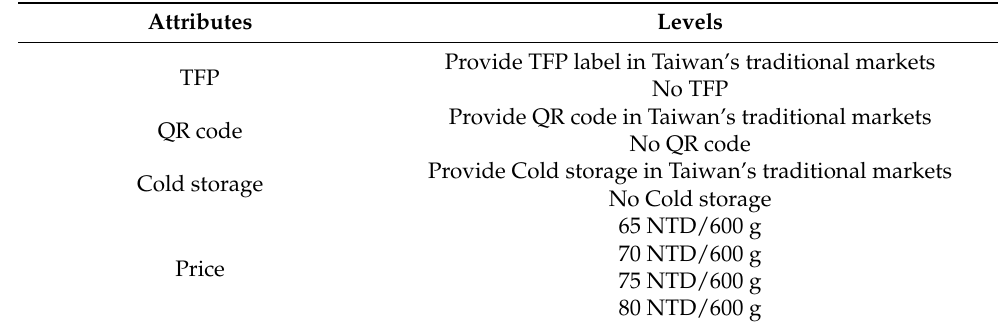
Table 1. Attributes and levels used in the CE design.